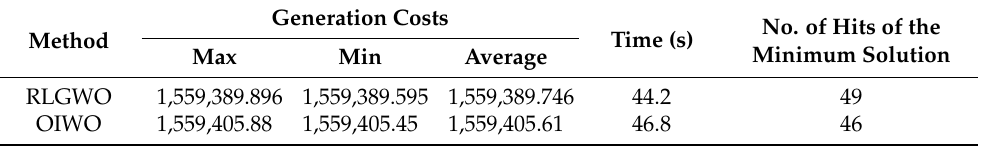
Table 8. Comparison between different methods taken after 50 trials (140-unit system with loss).